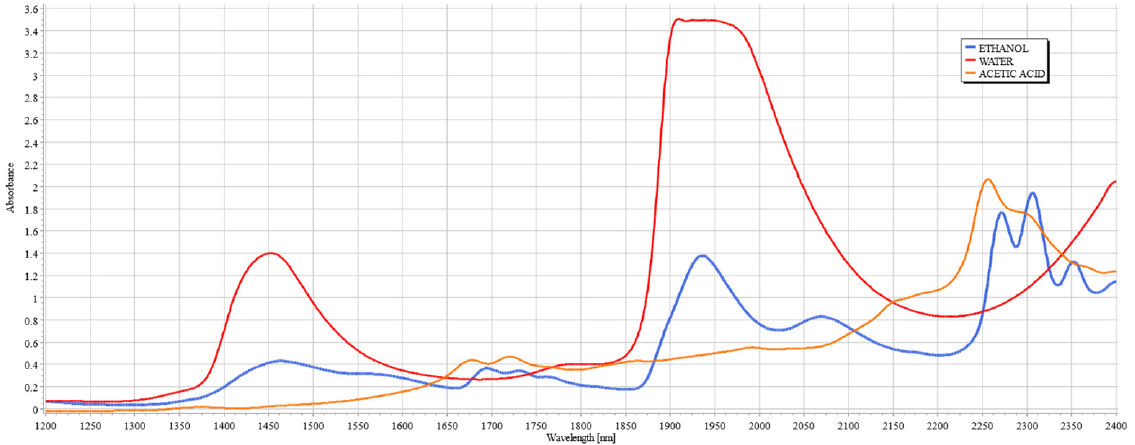
Figure 2. Spectra of water (red), ethanol (blue), and acetic acid (yellow) between 1200 and 2400 nm.